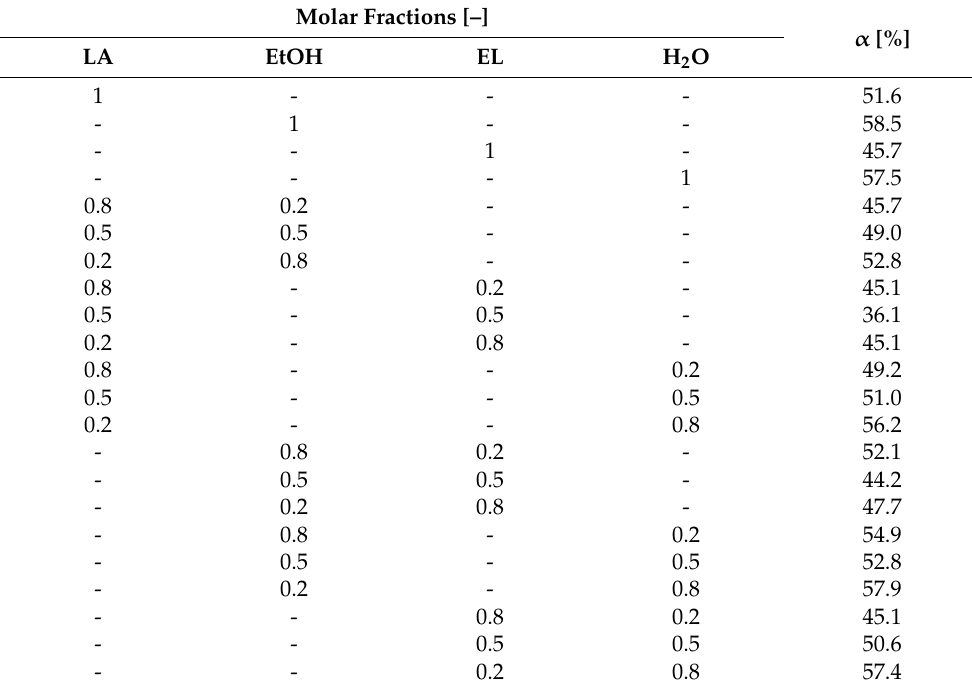
Table 3. Swelling percentage of Dowex 50WX8 when put in contact with different molar ratios of the components of our reactive